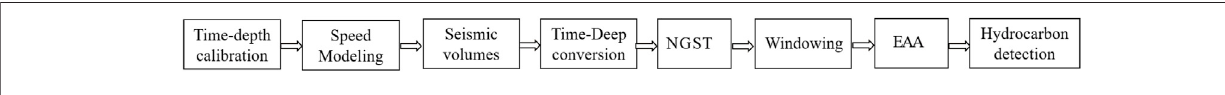
FIGURE 5 | Flow of the depth-domain seismic wave frequency dispersion